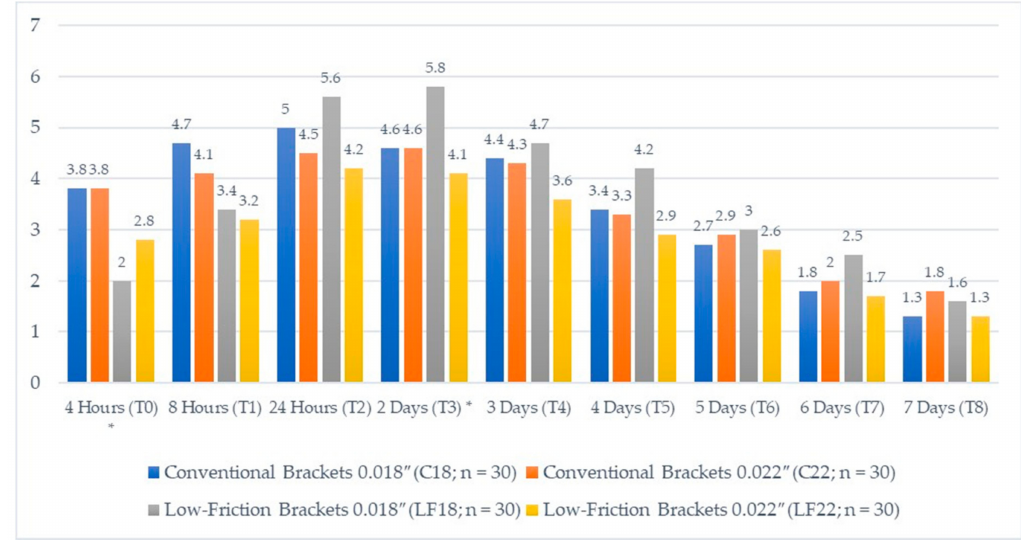
Figure 3. Comparison of pain measures by groups at di ff erent times using the VAS (* Statistically significant di ff erence at p < 0.05).